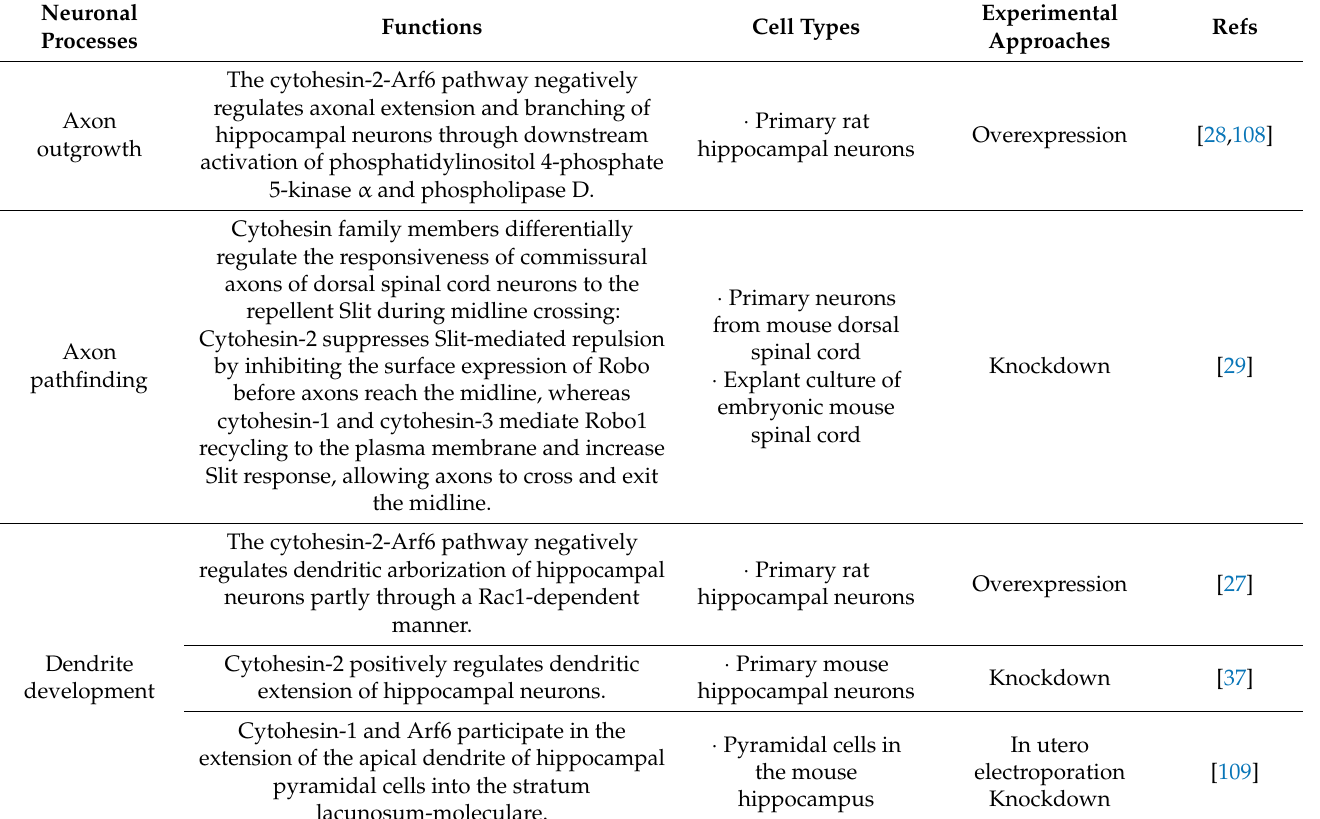
Table 2. Summary of physiological roles of cytohesins in